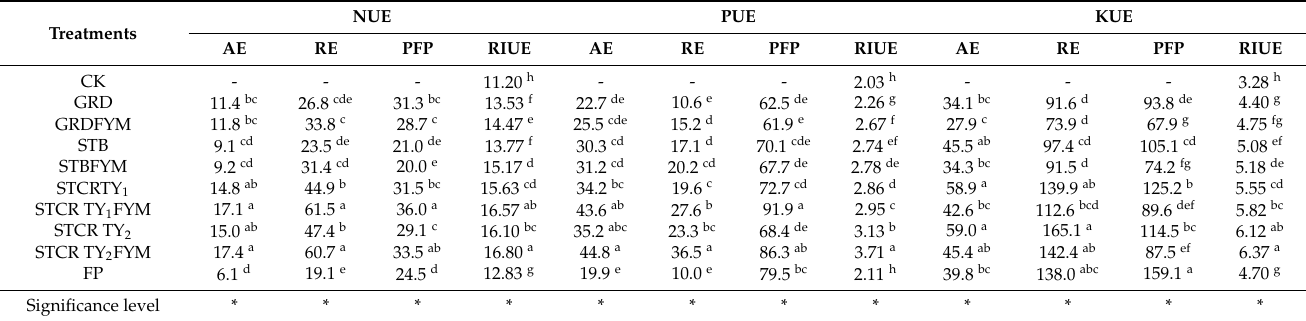
Table 10. Nutrient use efficiency in DSR, as influenced by different